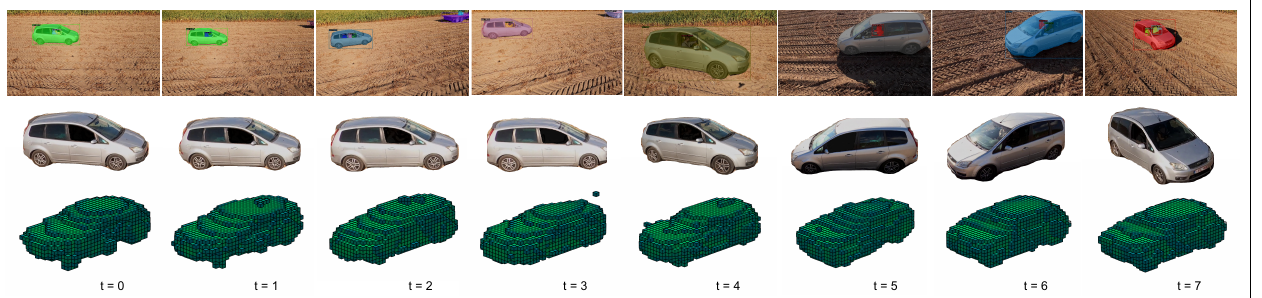
Figure 1. This figure illustrates the main idea of iteratively refining a 3D reconstruction. We generated a 3D reconstruction with the first available image. The next images were then used to improve upon this reconstruction using information from other viewpoints. The color of each voxel indicates the confidence of the model: green and blue represent high and low confidence, respectively. The video clip was captured with a GoPro carried by a Cinelog35 FPV drone. We then extracted the car from the images using an off-the-shelf segmentation model [17]. The reconstructions were obtained with the iterative model discussed in this